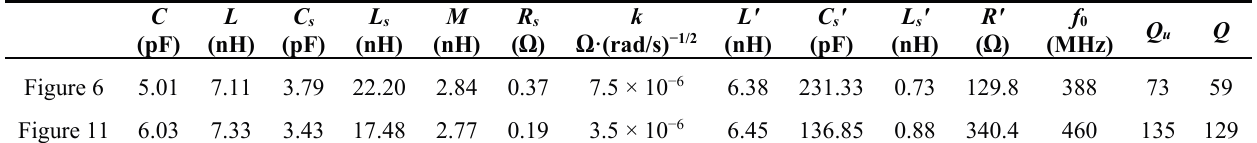
Table 3. Extracted circuit elements of the models in Figure 5 for the S-SRR-loaded CPWs of Figures 6 and 11 with 90° orientation.